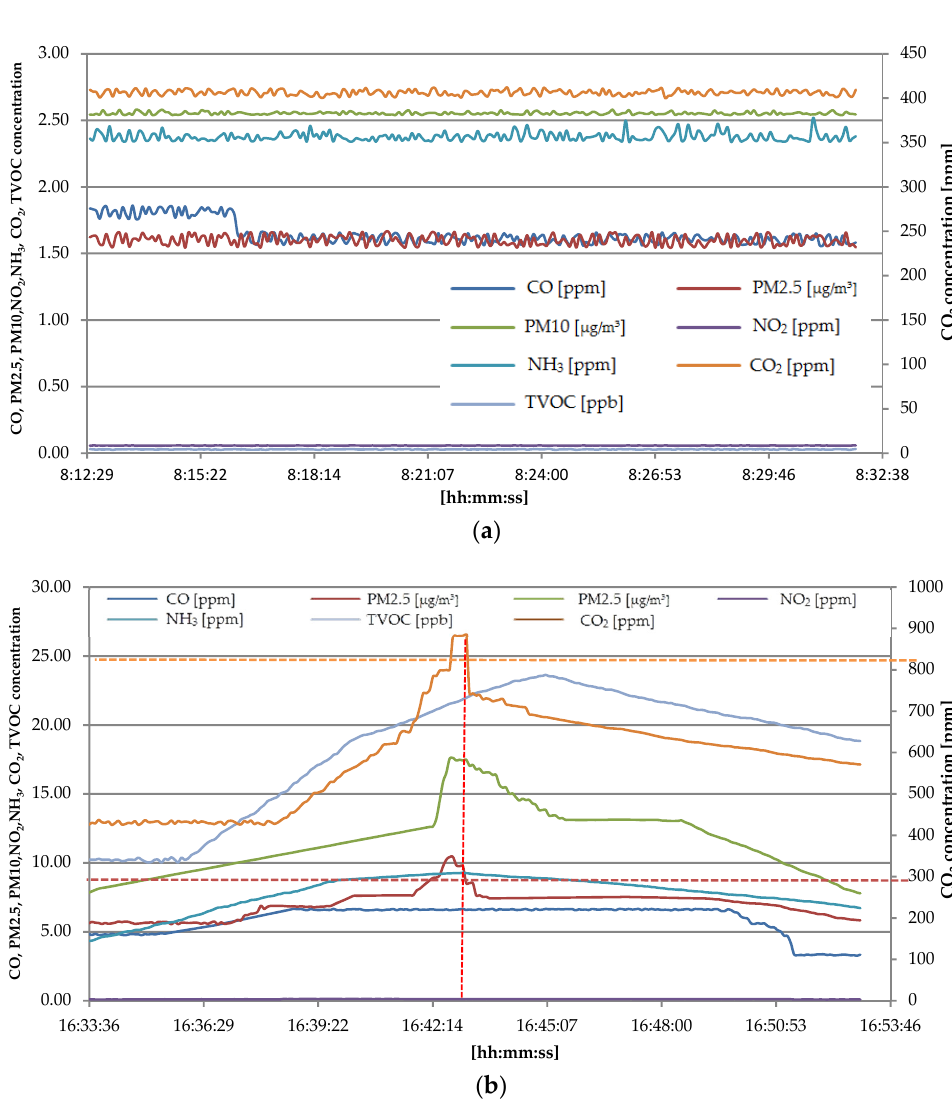
Figure 8. Time trend of the air concentrations of gaseous and particles species acquired by developed drone, using a sampling period of 5 s: first test campaign in a suburban area ( a ) and close a very busy state road ( b ).